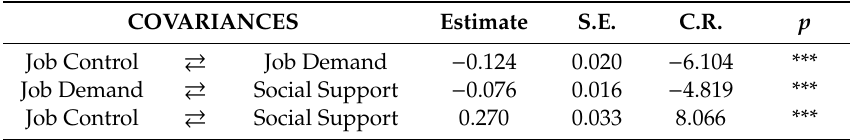
Table 5. Covariances between the exogenous constructs.